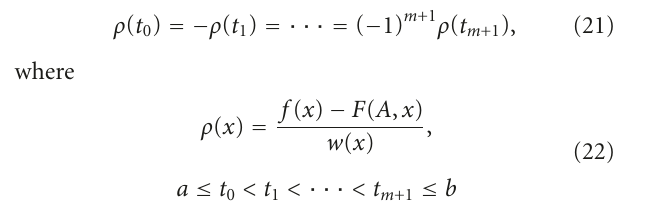
Figure 5: Directional filter bank frequency partitioning (cid:4) = 3 and there are 2 3 = 8 real wedge-shaped frequency